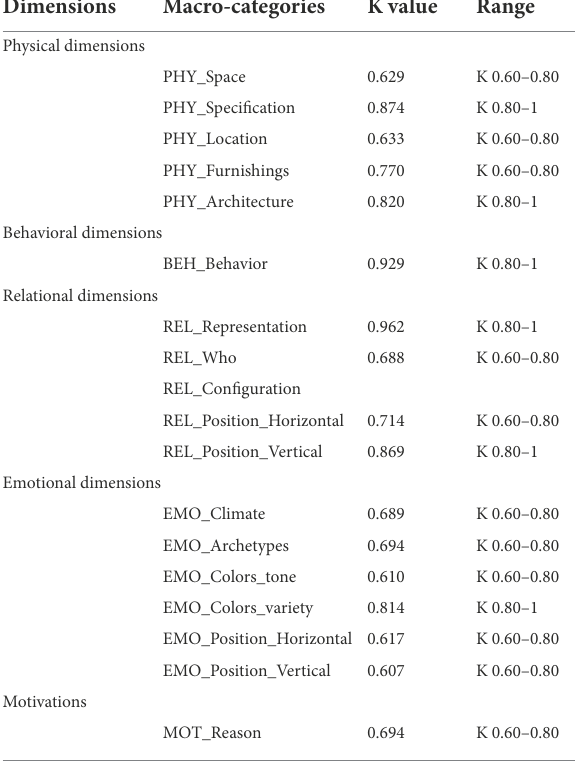
TABLE 6 Categorical inter-rater reliability for each